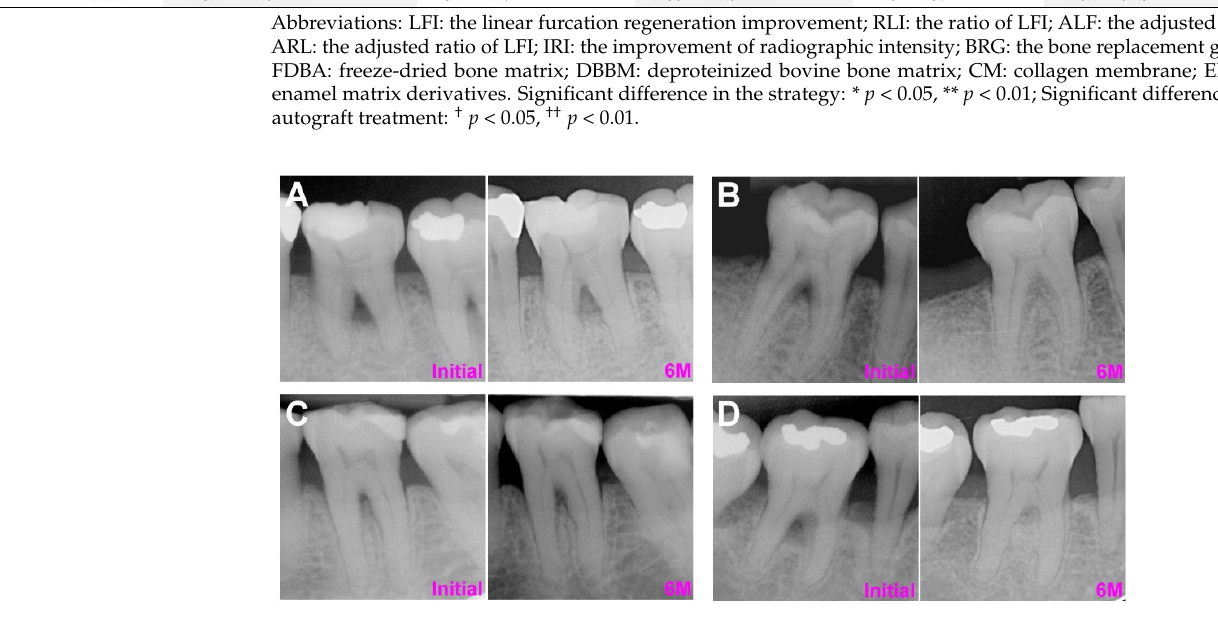
Figure 2. The representative pure furcation defect cases at initial (pre-operative phase) and 6 months following the regenerative procedure. ( A ) Autograft with CM ( B ) DBBM with CM. ( C ) Autograft with EMD. ( D ) DBBM with EMD. Abbreviations: CM: collagen membrane; DBBM: deproteinized bovine bone matrix; EMD: enamel matrix derivatives